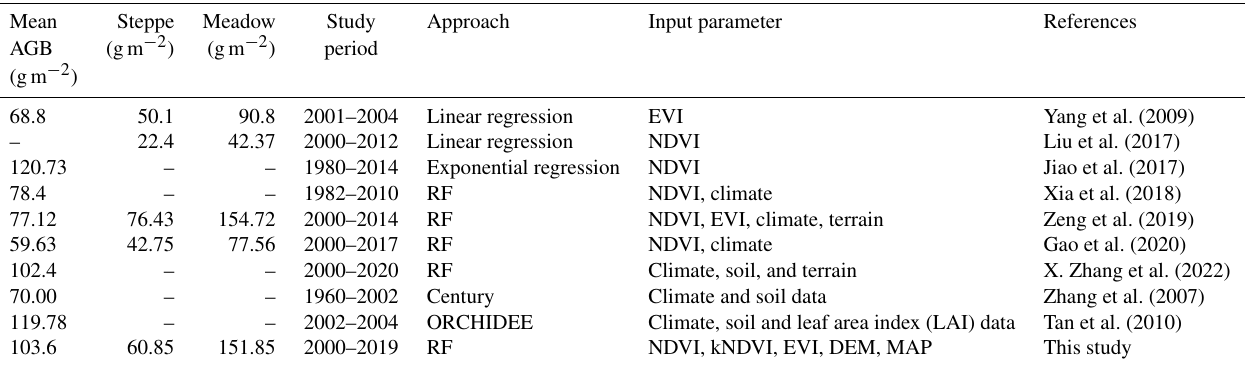
Table 5. Comparison of AGB estimation results of different studies on the QTP. Mean Steppe Meadow Study Approach Input